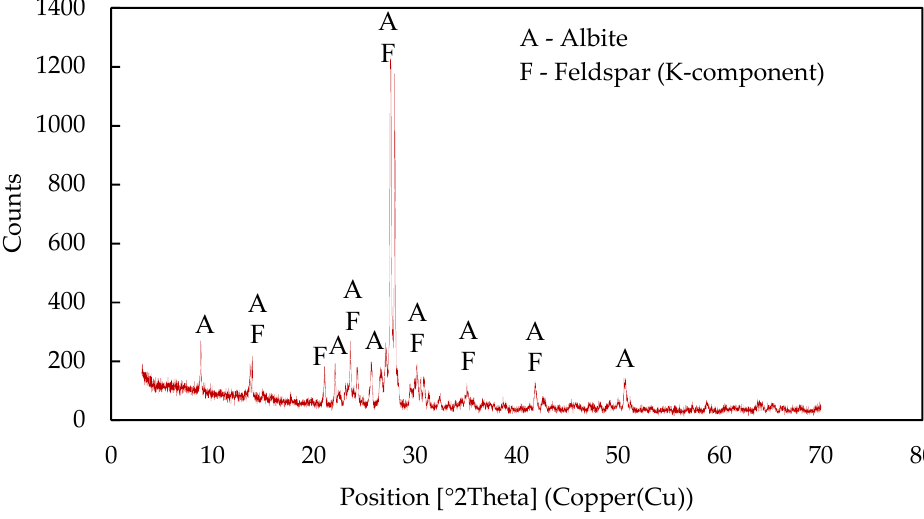
Figure 3. X-ray diffraction patterns of the potassium feldspar sample. The chemical and mineralogical properties of samples were defined with a differential thermal analysis (DTA) and the thermogravimetric analysis (TGA) equipment’s STA 449 F3 Jupiter ® thermal analyzer (NETZSCH, Selb, Germany). DTA and TGA curves of wollastonite-calcite, calcite concentrate (from flotation), and feldspar samples are illustrated in Figures 4, 5, and 6, respectively.